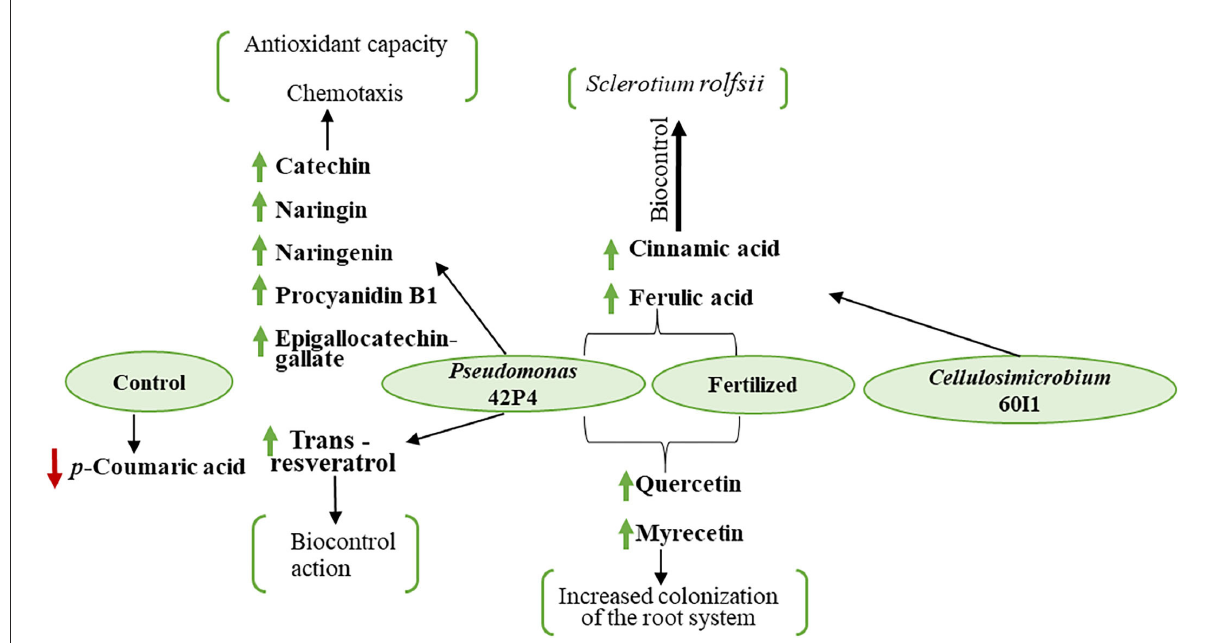
FIGURE7 Summary diagram of the main phenolic compounds in pepper plants grown in pots and treated with: Fert: Fertilized; 42P4: Pseudomonas 42P4; 60I1: Cellulosimicrobium 60I1 and Control (without